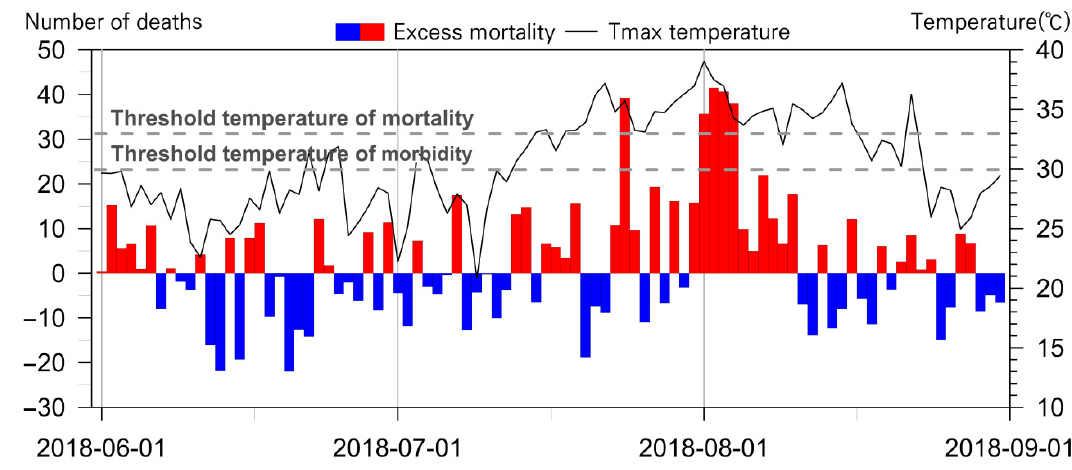
Figure 5. Comparison of daily excess mortality and the two threshold temperatures in Seoul, 2018.